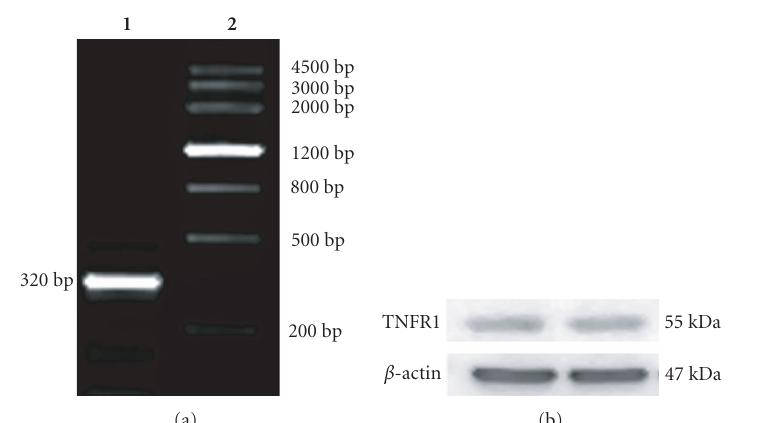
Figure 1: TNFR1 expression in EC109 cells. (a) Expression of TNFR1 mRNA in EC109 detected by RT-PCR. (1) TNFR1; (2) DNA marker. (b) Expression of TNFR1 at the protein level in EC109 cells detected by Western blot. Two bands with a molecular weight of 55kDa are expressed in EC109.